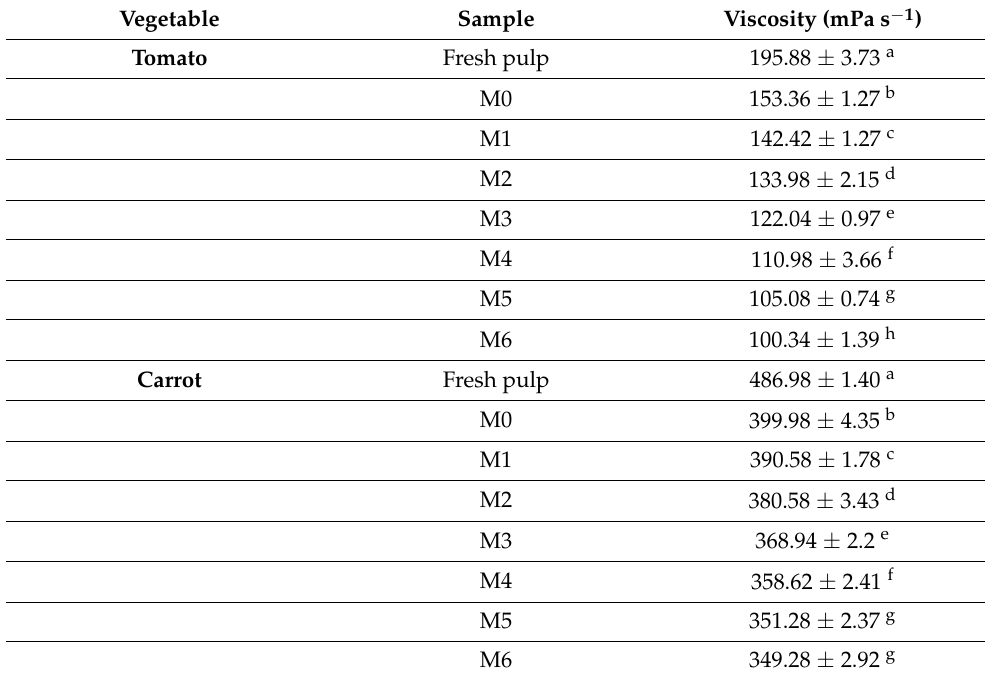
Table 2. Pulps’ viscosity ( n = 5) from fresh to freezing storage of baby carrot and cherry tomato pulps for 6 months were expressed in mPa s − 1 . Columns corresponding to the same vegetable with different superscript letters are significantly different ( p <